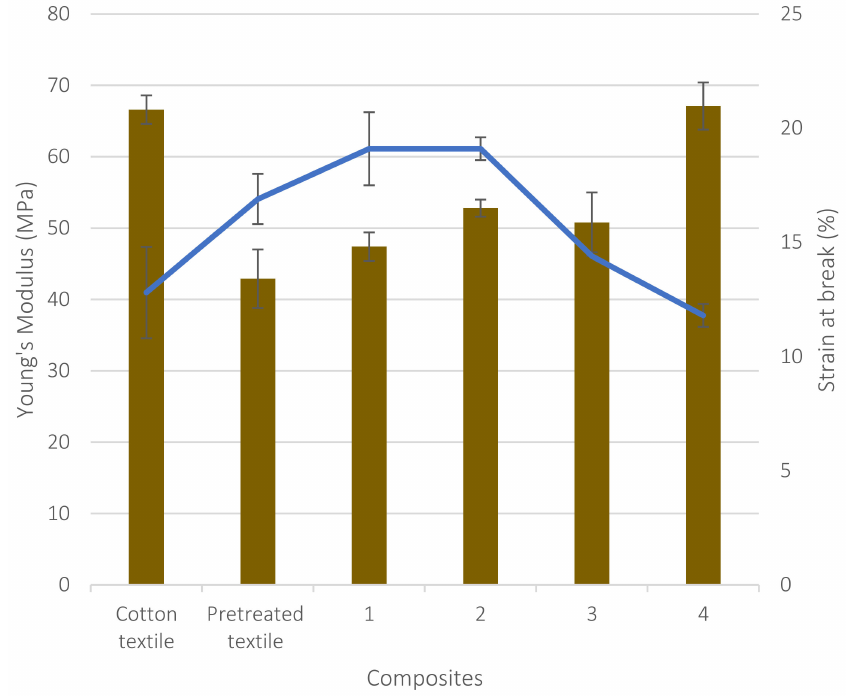
Figure 2. Average tensile strength and strain at the breaking point of cotton textiles, pretreated textiles with H 2 O 2 , and